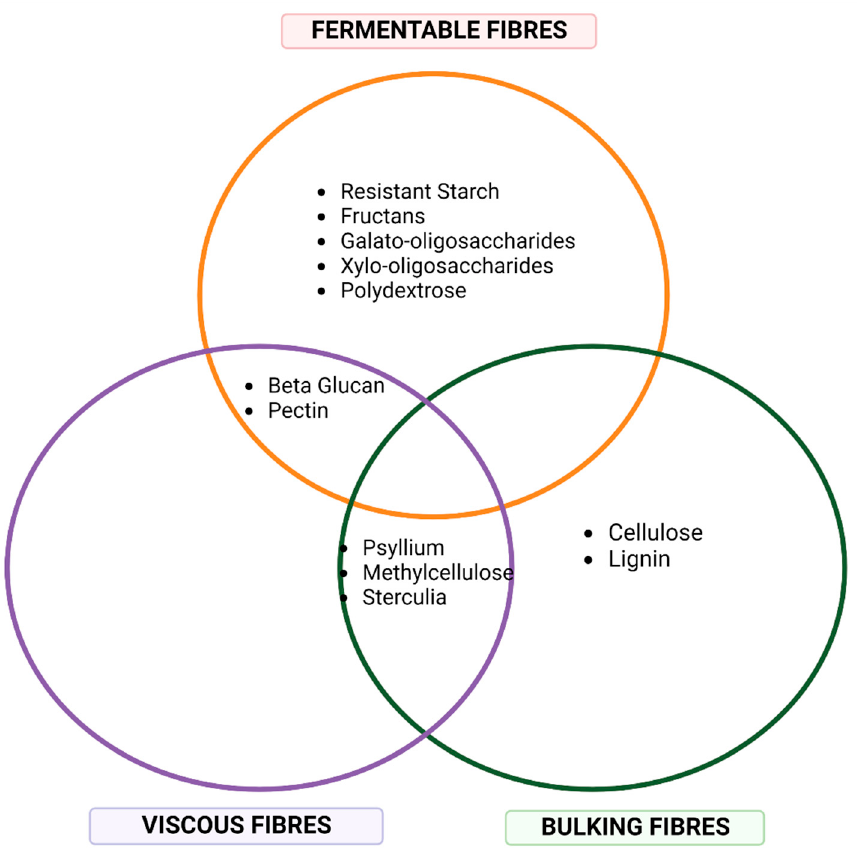
Figure 4. A venn diagram placing dietary fibre types in relation to their associations with bulking, fermenting and viscous functions. This is not a comprehensive overview of fibre types or functional associations but aims to demonstrates the wide diversity of the dietary fibre class. Created with Biorender.com.